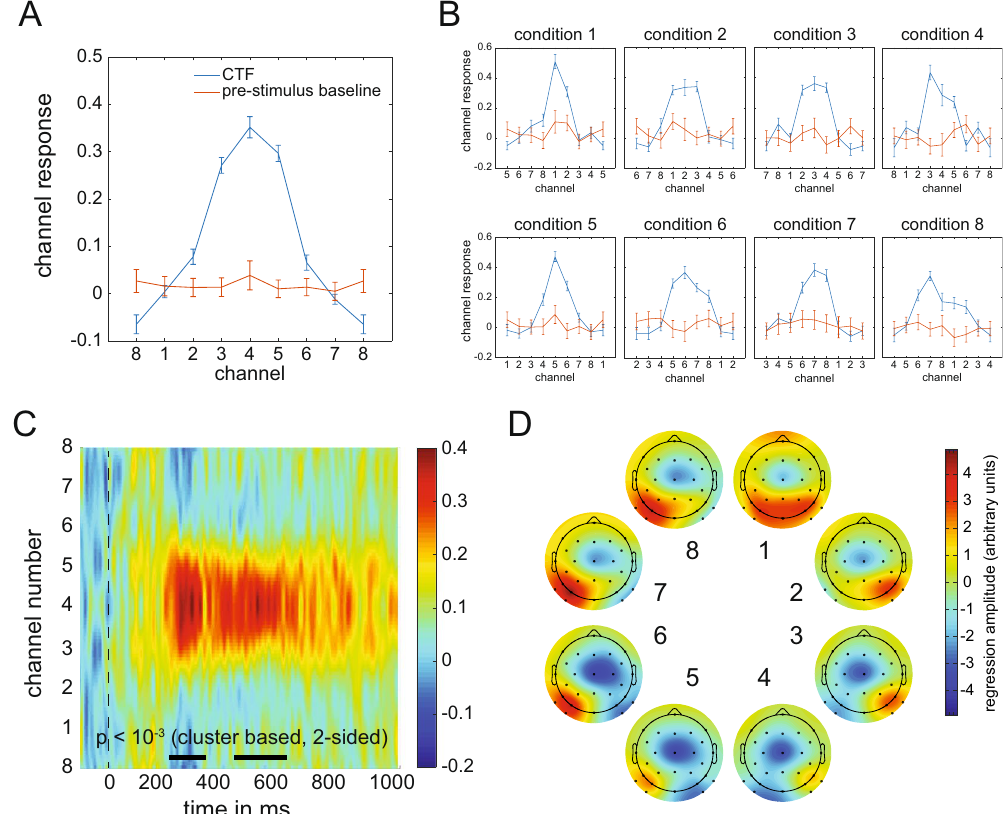
Figure 8. Channel Tuning Functions (CTF). ( A ) CTF for the 260–270 ms window and CTF during baseline ( − 100 to 0 ms) obtained by shifting the individual condition CTFs to align to the same channel. ( B ) CTFs for individual conditions show that the CTF is not driven by particular target positions. ( C ) CTF development over time in which color reflects channel responses. The black line near the time axis shows the time windows where the center position channel has significantly stronger channel responses than the outer boundary channel (p < 10 − 3 , cluster based permutation test). ( D ) Topographic weight plots for each condition in the 260–270 ms time window. Weights from forward models are directly interpretable in terms of neural sources (Haufe et al . 11 . These plots therefore show how neural activity changes as a function of variability in target